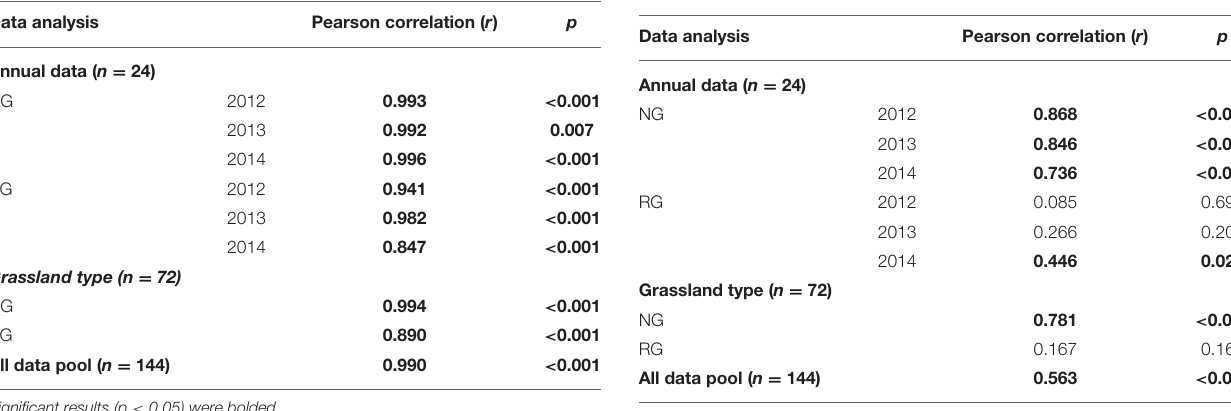
TABLE 3 | Correlations between plant community total and belowground biomass in the natural (NG) and restored (RG) alpine grasslands around Qinghai Lake Basin.